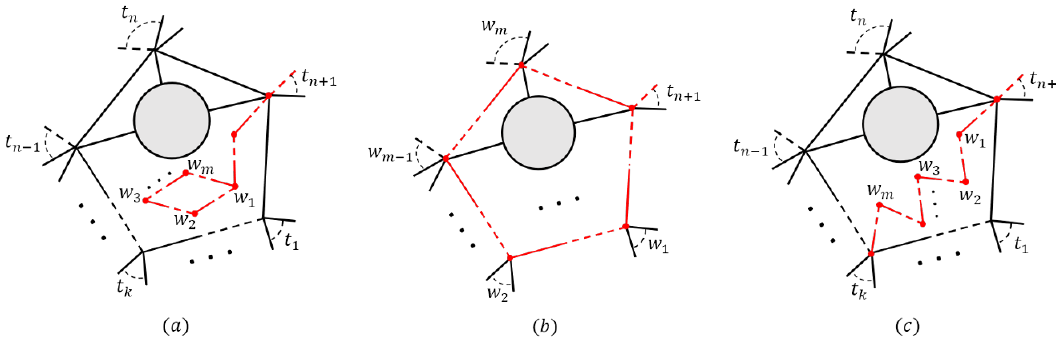
Figure 5 . Various possibilities: (a) corresponds to the existence of an internal a - r loop, which is described by (4.1). In (b), there is an a - r loop which starts and ends at the operator with the largest time, which is described by (4.2). In (c) there is an a - r line which connects the operator with the largest time with another operator, described by